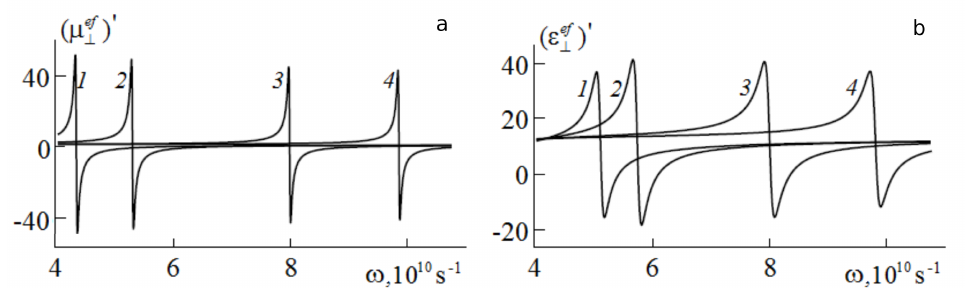
Figure 2. Frequency dependences of the real parts of the effective permeability ( a ) (controlled TE wave) and permittivity ( b ) (controlled TM wave) of a finely layered structure at H 0 = 1.5, 2,